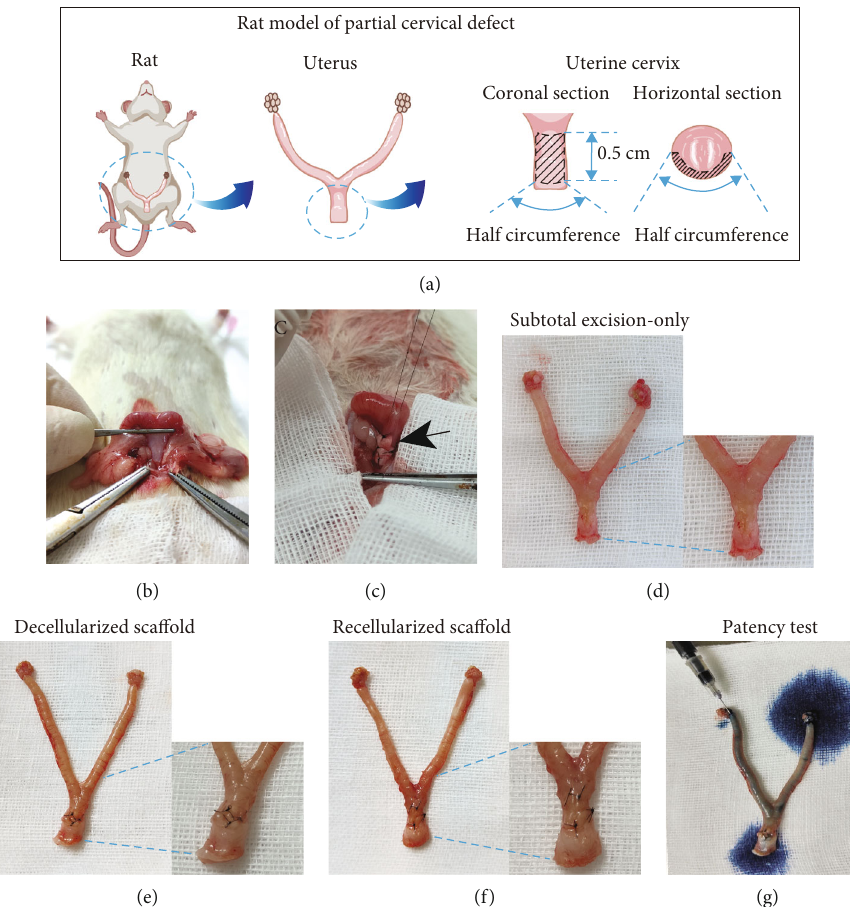
Figure 4: Surgical processes and gross examination of reconstruction of partial uterine cervical defect in rat. The schematic diagram of establishing mouse model of partial cervical injury (a). Surgical processes for two sca ff old groups were shown: after exposure of uterine cervix (b), a tissue segment was excised from the cervix, then sca ff old was implanted, respectively, with 6-0 sutures (c). The black arrow indicates the implantation site. Gross observation of rat uterus from the subtotal excision-only group (d), decellularized sca ff old group (e), and recellularized sca ff old group (f) was shown, respectively. Uterine patency test showed that the solution fl owed freely out of the cervical end of the uterus, with the recellularized sca ff old group as an example